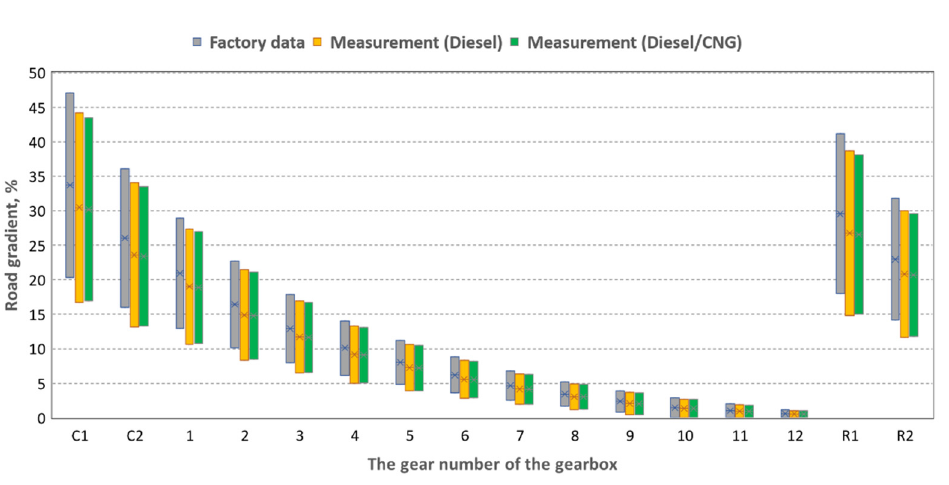
Figure 8. Change of the achieved maximum speed value depending on the road inclination angle. Figure 8. Gradeability in each gear of the